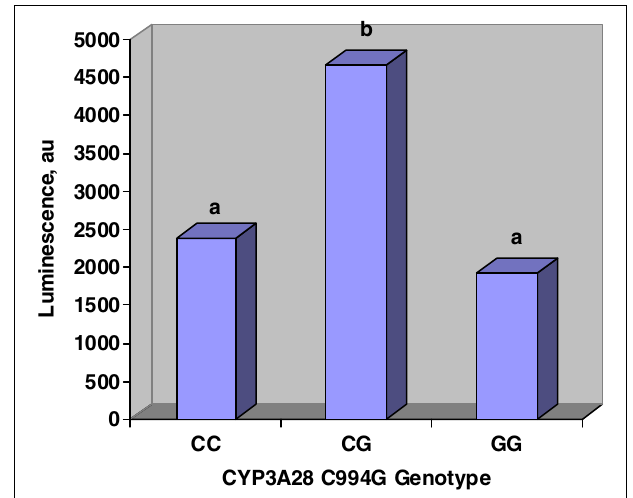
FIGURE 2 | Main effects of CYP3A28 genotype on CYP450 activity in vitro . Genotype was determined at C994G mutation. Urine was incubated in P450-Glo assay and luminescence was directly proportional to CYP450 activity. Genotype affected ( SE = 770 ; P < 0 . 03 ) urine inhibition of CYP450 activity. Fescue cultivar did not affect ( P > 0 . 1 )